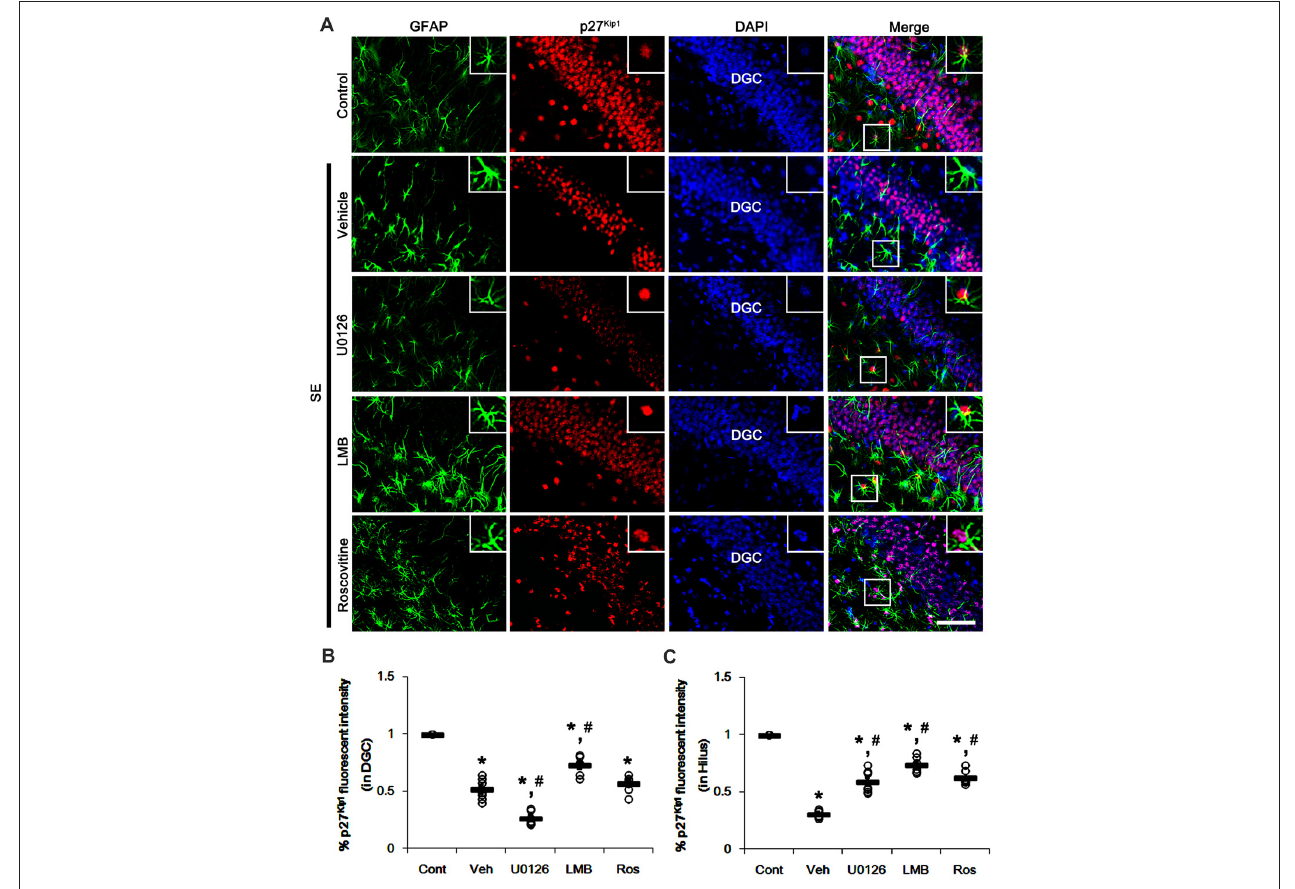
FIGURE 4 | Effects of U0126, LMB and roscovitine on p27 Kip1 expression in the dentate gyrus following SE. (A) Representative double immunofluorescent images for GFAP and p27 Kip1 expression. SE reduces nuclear p27 Kip1 expression in dentate granule cells (DGC) as well as astrocytes. As compared to vehicle, U0126 aggravates the decline of nuclear p27 Kip1 expression in DGC, while LMB attenuates it. Roscovitine does not affect SE-induced reduction in nuclear p27 Kip1 expression in DGC. However, three distinct compounds mitigate the decline of nuclear p27 Kip1 expression in astrocytes. Insert images are high magnification of rectangles in merge panels. Bar = 50 and 12.5 (inserts) µ m. (B,C) Quantifications of the number of nuclear p27 Kip1 expression in DGC (B) and astrocytes (C) . Open circles indicate each individual value. Horizontal bars indicate mean value. Error bars indicate SEM ( ∗ , # p < 0.05 vs. control and vehicle, respectively; n = 7,